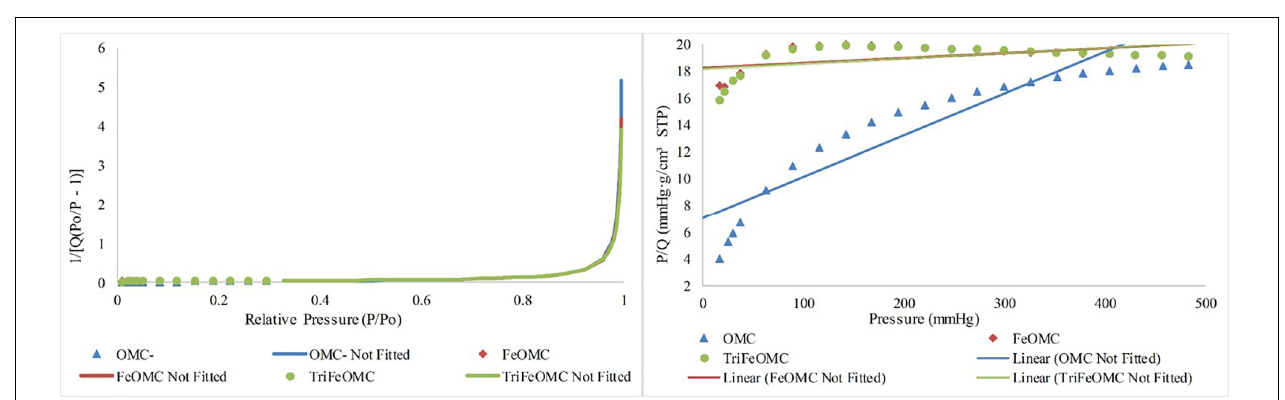
FIGURE 3 | The Langmuir and BET surface area plots of OMC, FeOMC and TriFeOMC.